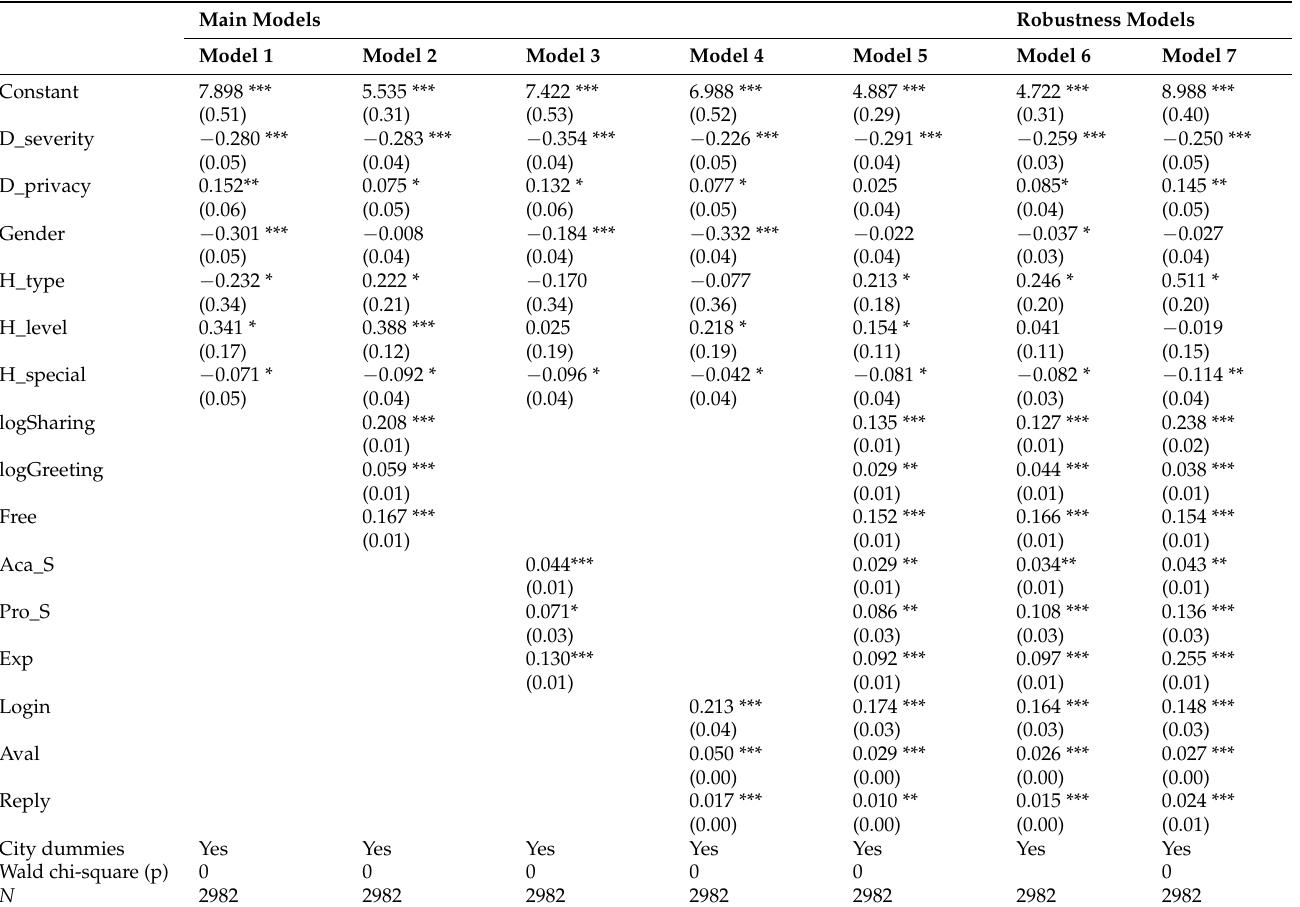
Table 3. Regression